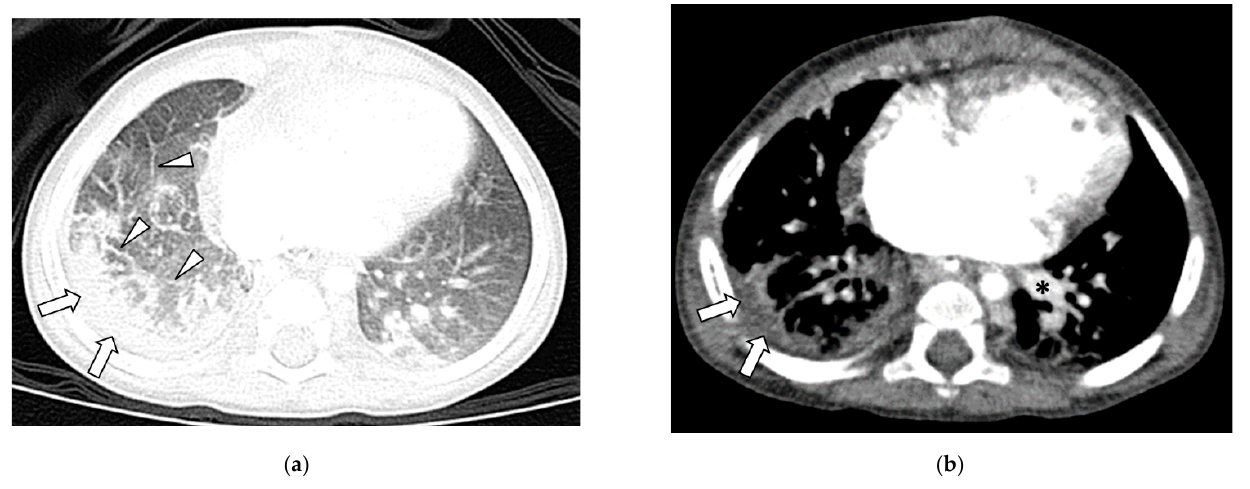
Figure 1. Fourteen-month-old girl with right sided pulmonary vein stenosis. ( a ): Axial lung window CT image demonstrates septal thickening (arrowheads) and pleural thickening (arrows) in the right hemithorax. ( b ): Axial contrast-enhanced soft tissue window CT image shows pleural thickening (arrows) in the right hemithorax. Right pulmonary veins are absent. Left pulmonary vein (asterisk) is visualized.